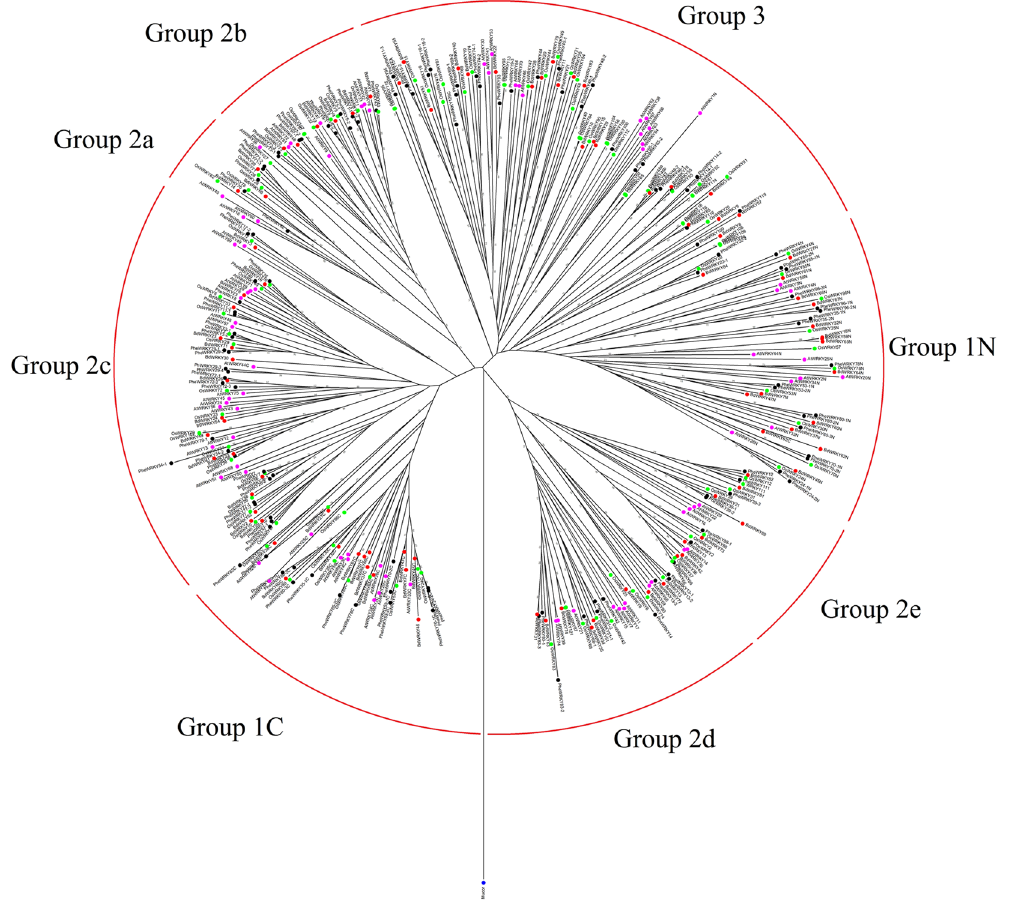
Figure 3. Rooted phylogenetic tree of the WRKY TF families. A. thaliana , O. sativa , B. distachyon , and P. patens . ‘Group 1 N’ and ‘Group 1 C’ indicate N-terminal or C-terminal WRKY domains, respectively, in group 1. P. edulis , A. thaliana , O. sativa , B. distachyon , and P. patens proteins are indicated by black, green, purple, red, and blue dots, respectively.